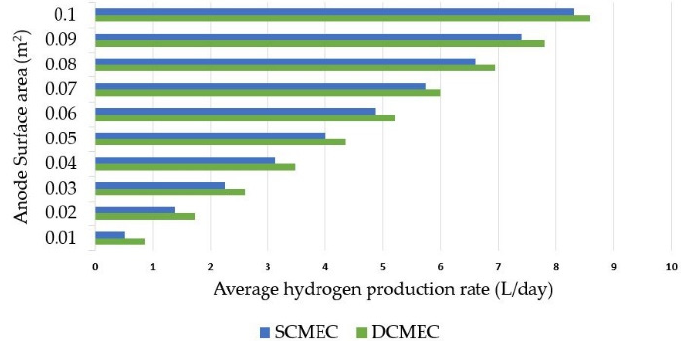
Figure 8. The effect of anode surface area on hydrogen production rates.